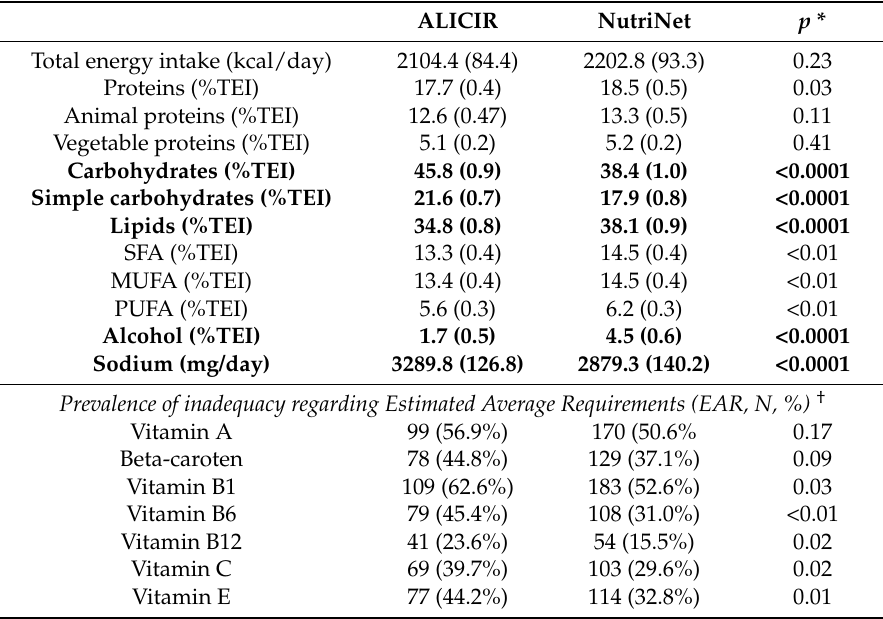
Table 4. Comparison of adjusted nutrient intakes between controls and cases ( N =